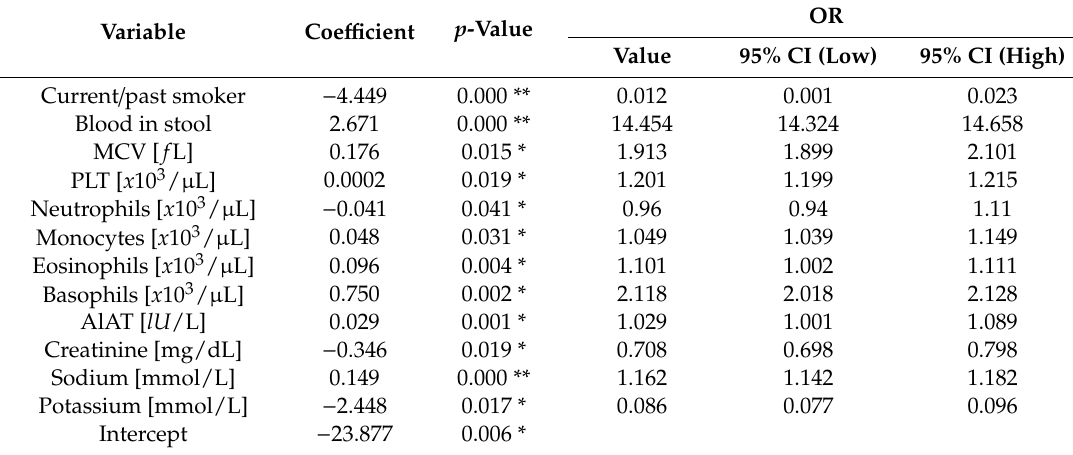
Table 2. Coe ffi cients with the p -value and odds ratio Table 2. Coefficients with the p -value and odds ratio (OR).